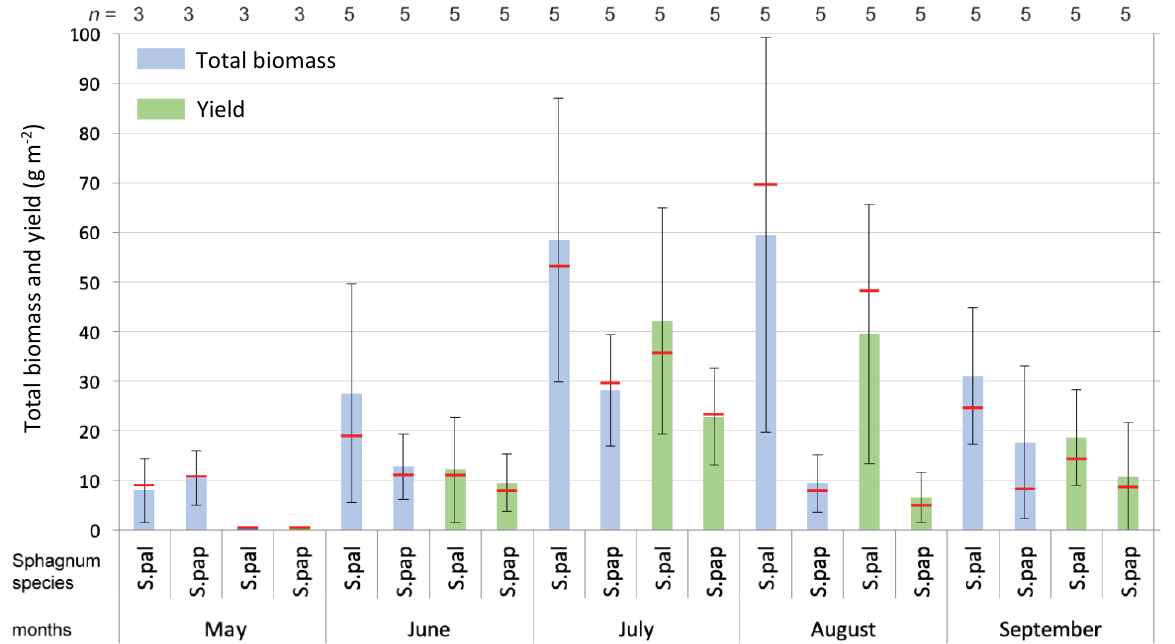
Figure 4. Total biomass (all flowering/non-flowering plants in the plots) and yield (all flowering plants) of Drosera rotundifolia growing on Sphagnum palustre (S.pal) and S. papillosum (S.pap) fields between May/June and September in 2013 and 2014. The vertical bars show the means, the whiskers the standard deviations, and the red lines the medians. Number of replicates ( n ) is written above each